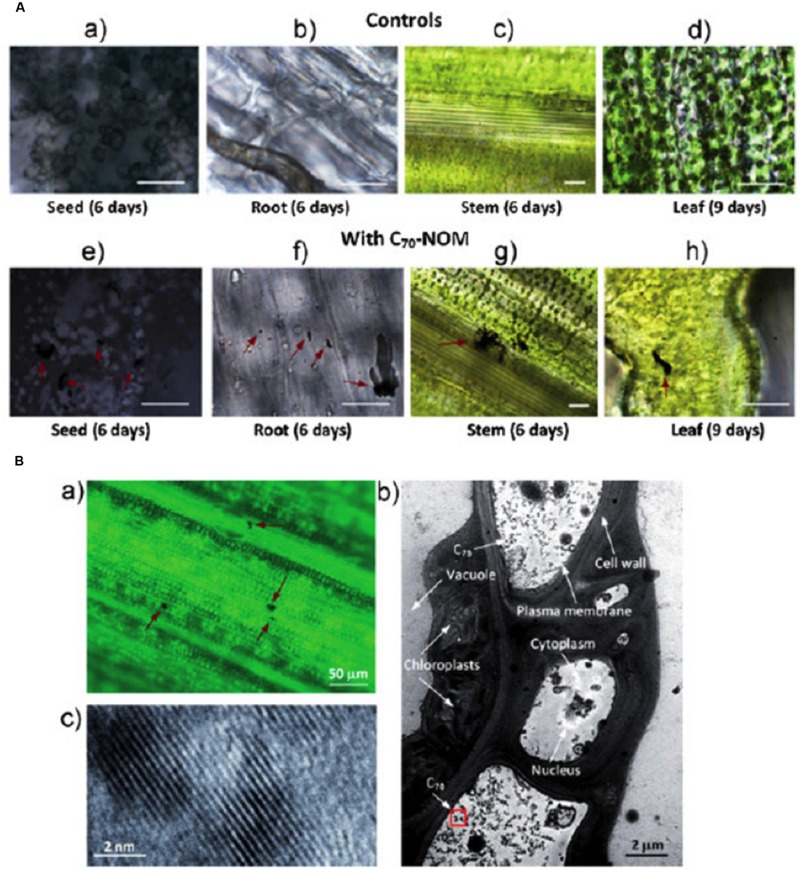
Bright-field images of rice plants showing C70 uptake. (A) Bright field images of root and leaf portions of 1-week-old rice seedlings. Control plants without any C70 (a–d) and treated plants showing C70 uptake (e and f). Arrows indicate the aggregation of nanoparticles in corresponding C70 treated plant tissues (scale bars are 20 μm). (B) (a) Bright field image of the leaf portion of a second generation rice plant. C70 aggregates were mostly found near the leaf vascular system. (b) TEM image of the leaf cells showing C70 particles (C70: 20 mg/L). (c) transmission electron microscopy (TEM) image of C70 particles with higher magnification. Reprinted from: Husen and Siddiqi (2014), Copyright © 2014 Husen and Siddiqi; licensee BioMed Central Ltd. [adopted from Lin et al. (2009), Copyright © 2009 Wiley-VCH Verlag GmbH & Co. KGaA, Weinheim].